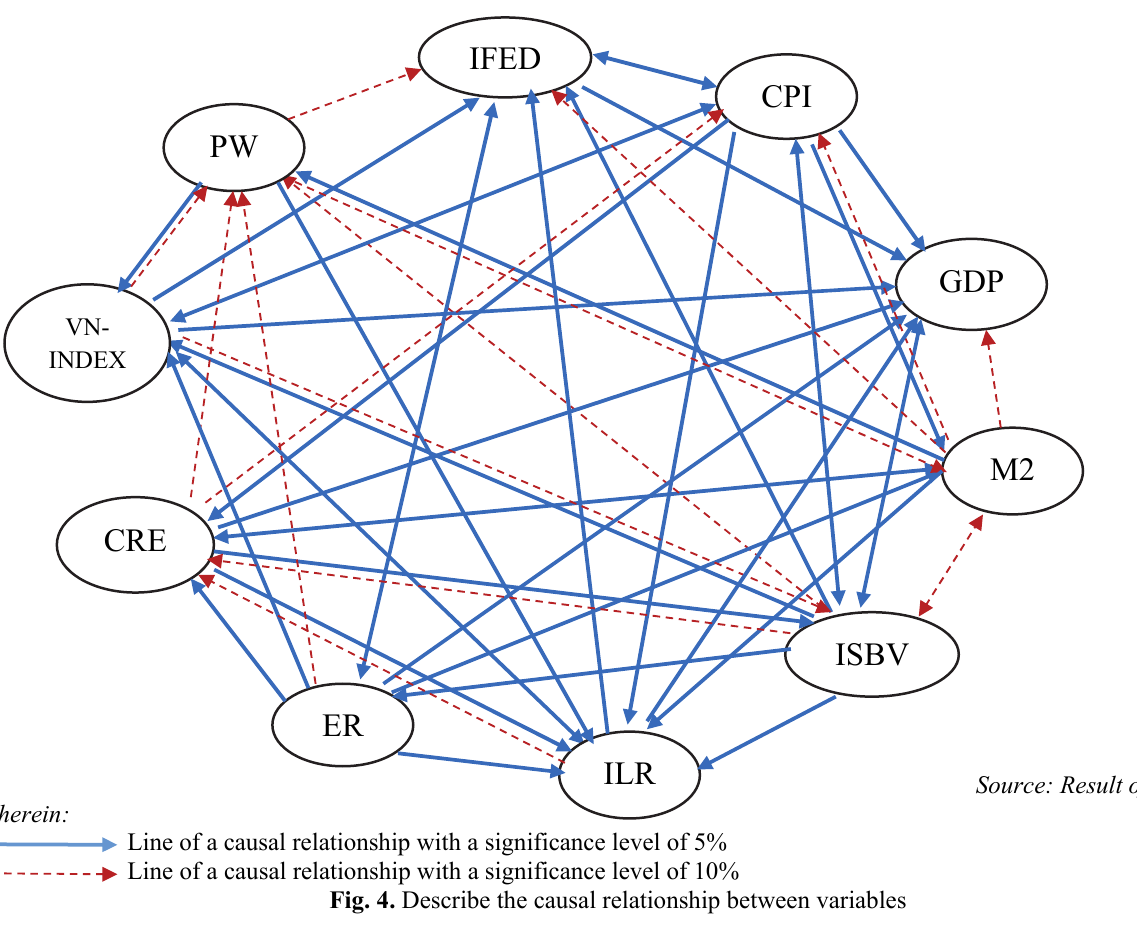
Fig. 4. Describe the causal relationship between variables